Question: Sum up the contents of this chart in one sentence.
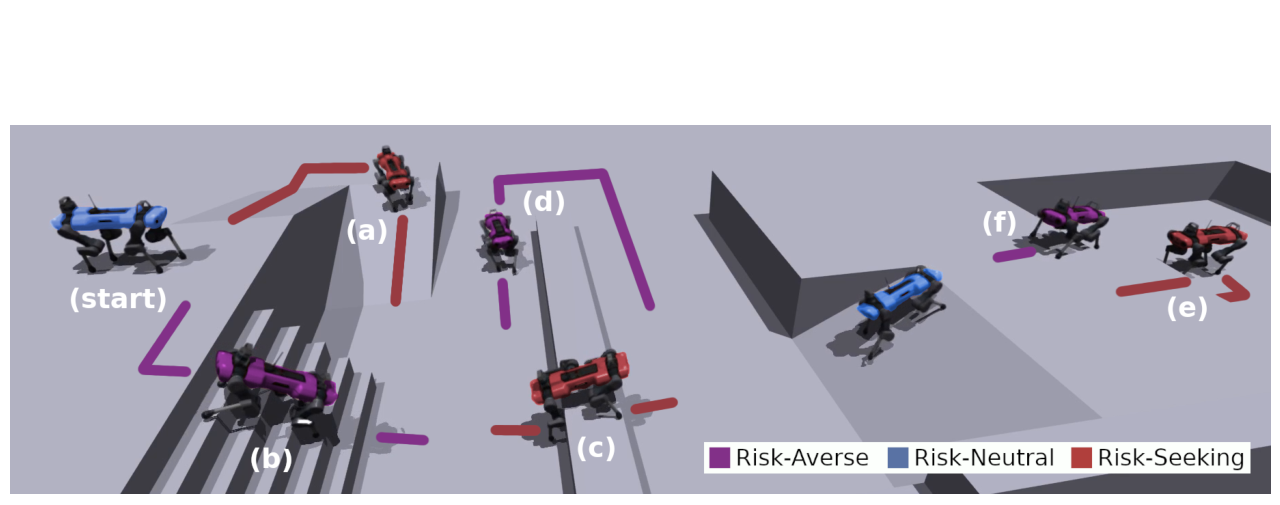
Answer: Robot operated remotely along an obstacle course. Depending on the chosen path, different risk sensitivities are preferable. For the incline along path (a), a risk-seeking policy (■) can be chosen for increased walking speed. Using a risk-averse policy (■) when descending the stairs along route (b) ensures the robot’s safety. A risk-averse policy (■) won’t climb the dangerous obstacle (c) and thus would have to walk around it, along route (d). Meanwhile, setting the policy to risk-seeking (■) allows the robot to surmount the obstacle (c). To step down into the deep pit along route (e), one must set the sensitivity to risk-seeking (■). The risk-averse policy (■) will refuse to step into the pit (f) as it may lead to a crash. Video: https://youtu.be/GGFXpF4qeVY.